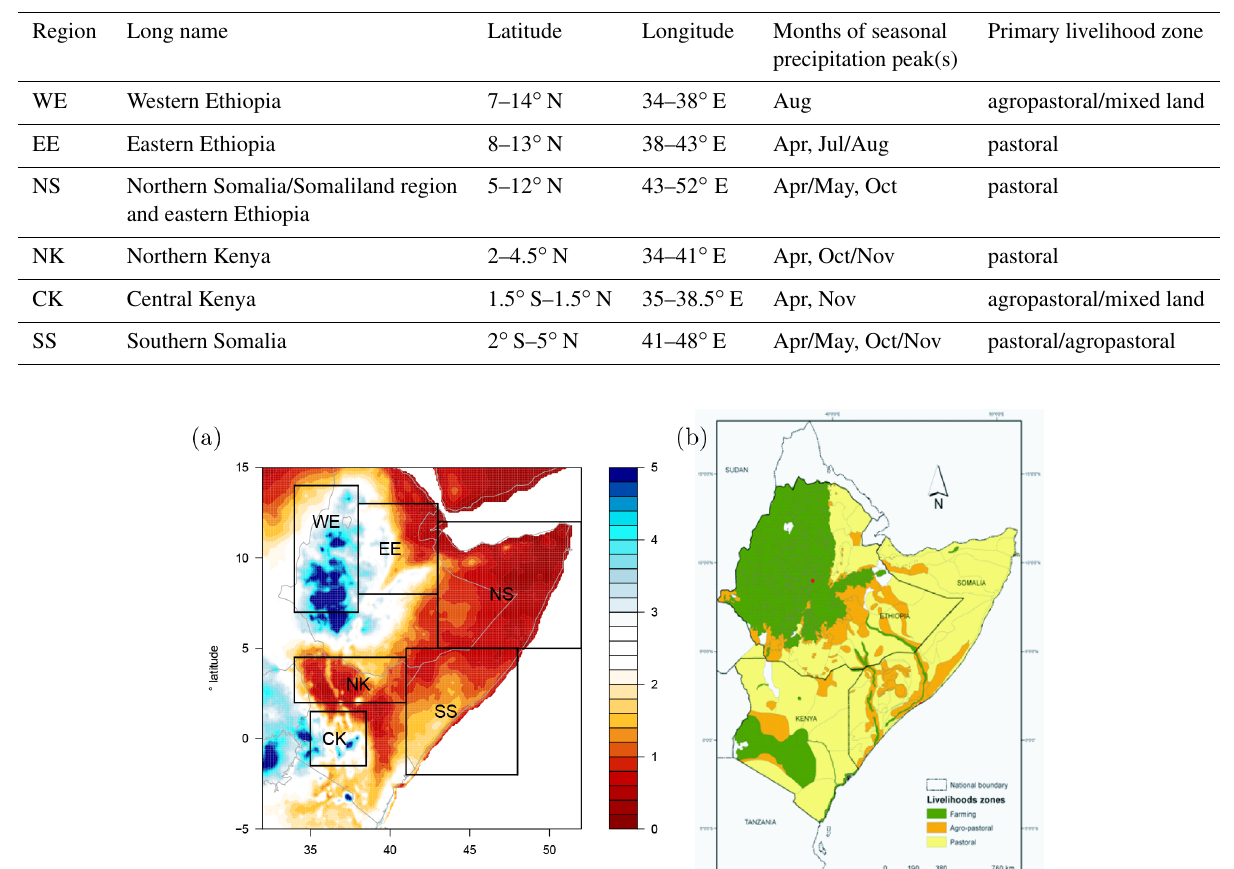
Table 1. The six study regions. See also Fig. 1.